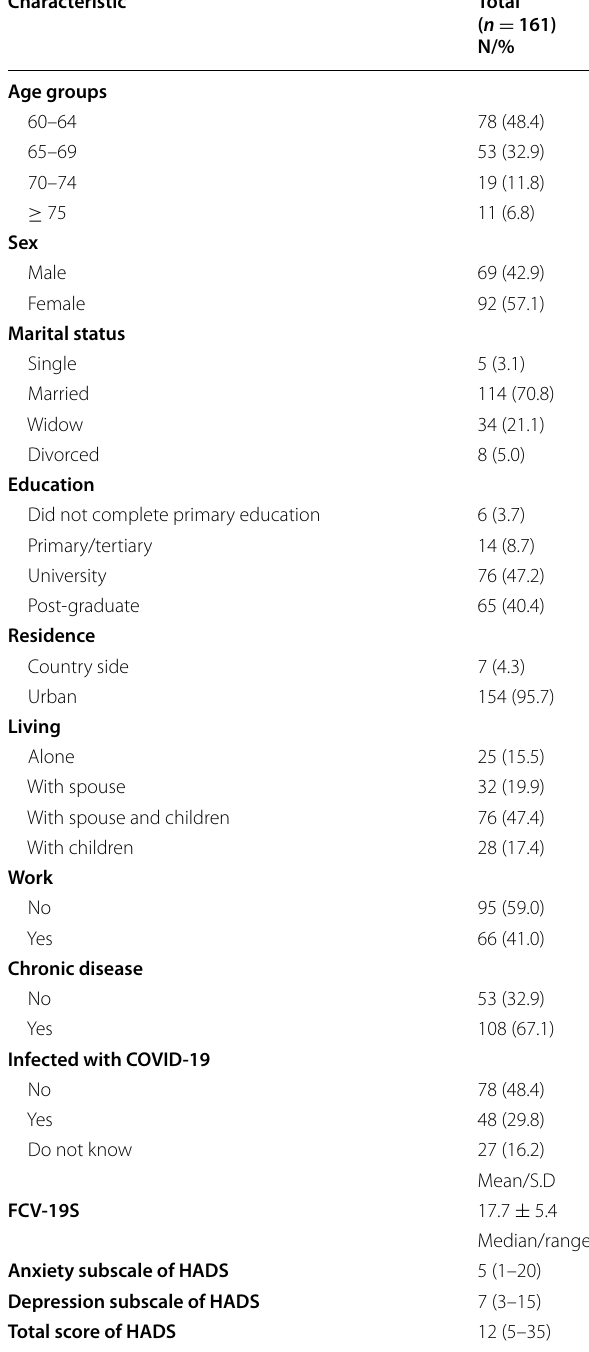
Table 1 Socio-demographic data among the studied